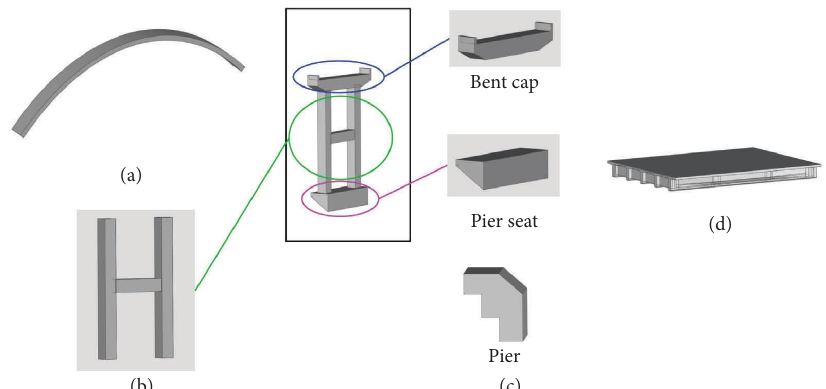
Figure 2: Illustrations of diferent components: (a) arch ring; (b) pier column and tie beam; (c) pier, pier seat, and bent cap; and (d) T-beam.